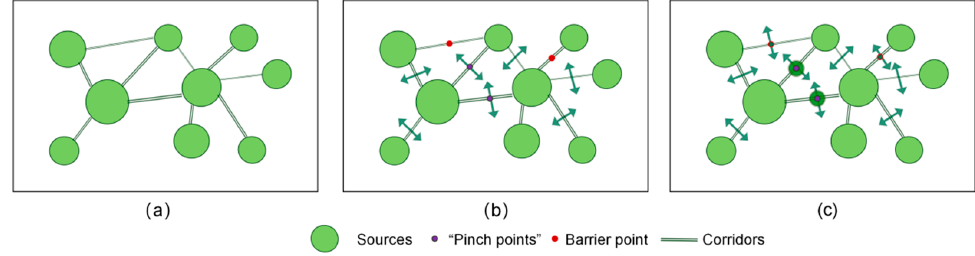
Figure 2. Principles of ecological network optimization. ( a ) Construction of ecological security pattern. ( b ) Ecological key point identification. ( c ) Optimizing Ecological Network.